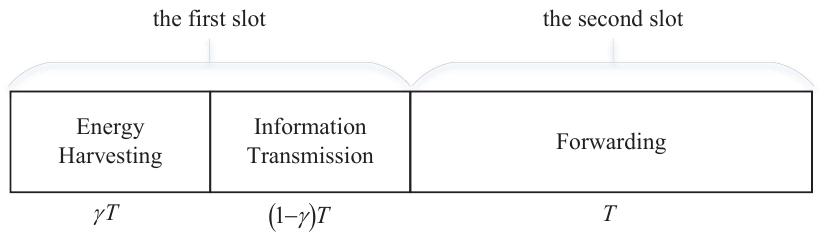
Figure 2. Slot-splitting